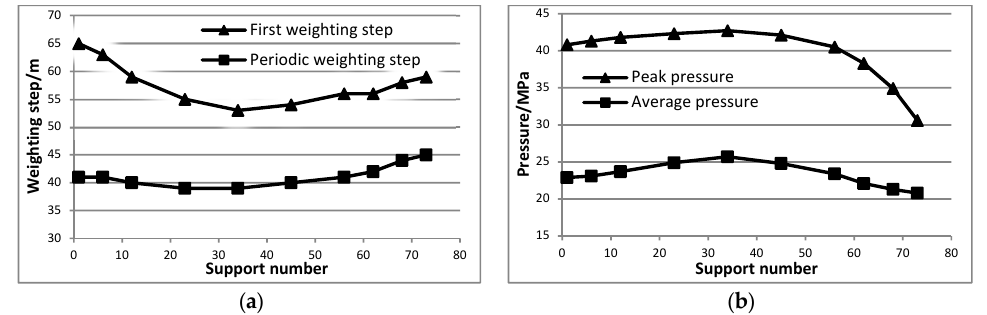
Figure 12 . Pressure statistics of hydraulic support in the longwall working face: ( a ) Weighting step; ( b ) Weighting strength.